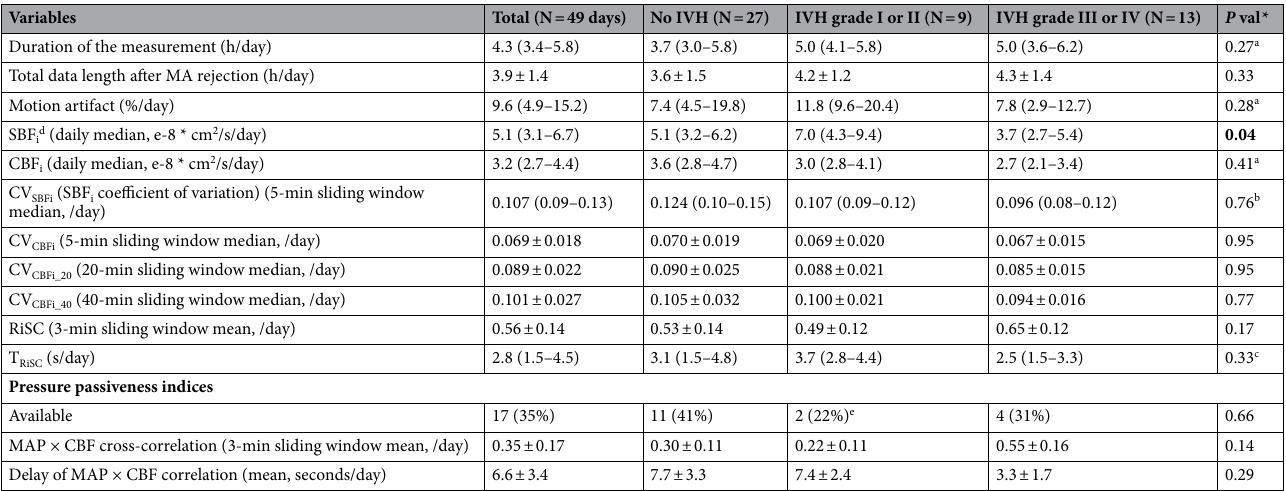
Table 3. DCS variables during the studies among N = 49 days by IVH status. Significant values are in bold. MA Motion artifact; * P values were obtained using a linear mixed model (when possible) to account for repeated measures in each subject. The P-values for categorical variables were obtained using Fisher’s exact test without accounting for repeated measures in each subject.; a log 10 () transformation was applied; b logit() transformation was applied; c Square root transformation was applied; d The variable passed the normality test but is presented in median (25–75th) for easy comparison with CBF i ; e The two measurements were from one subject; Data are presented as n (column %) for categorical variables, except when presented as a mean ± SD for normally distributed variables or when presented as a median (25–75th) for non-normal